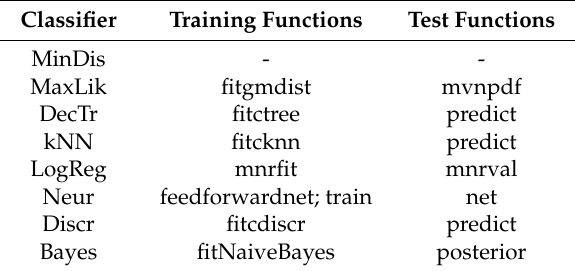
Table 2. MATLAB functions supporting the various classifiers.